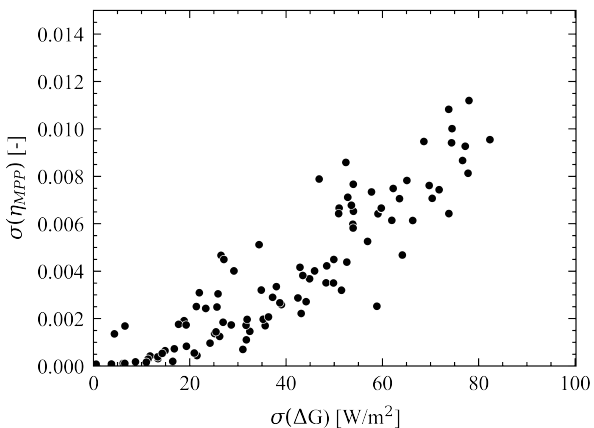
Figure 2. Daily dispersion of differences in irradiance, σ ( ∆ G ) , causes increased daily dispersion of the calculated efficiency, σ ( η MPP ) , for 100 randomly selected days. Two outliers were removed for